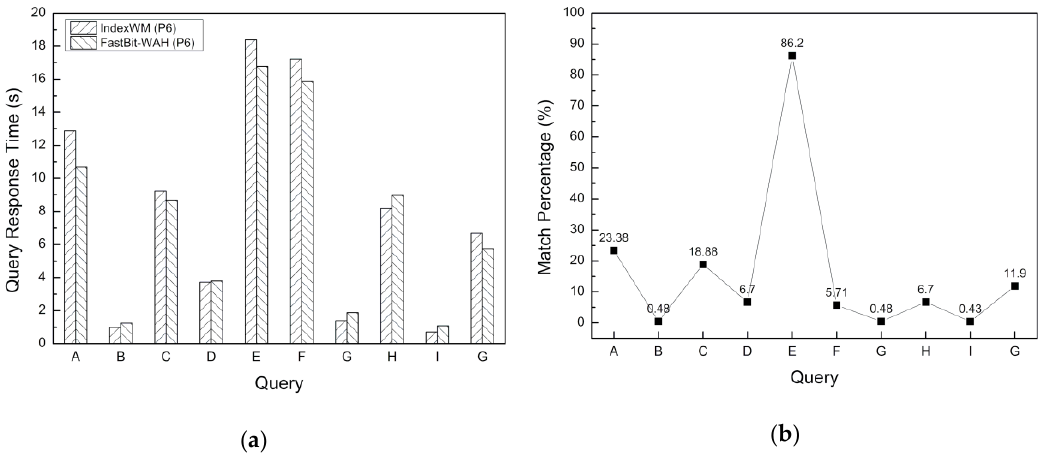
Figure 12. A comparison of query response time. ( a ) Query response time on dataset P6; ( b ) the percentage of matched packets on dataset P6.